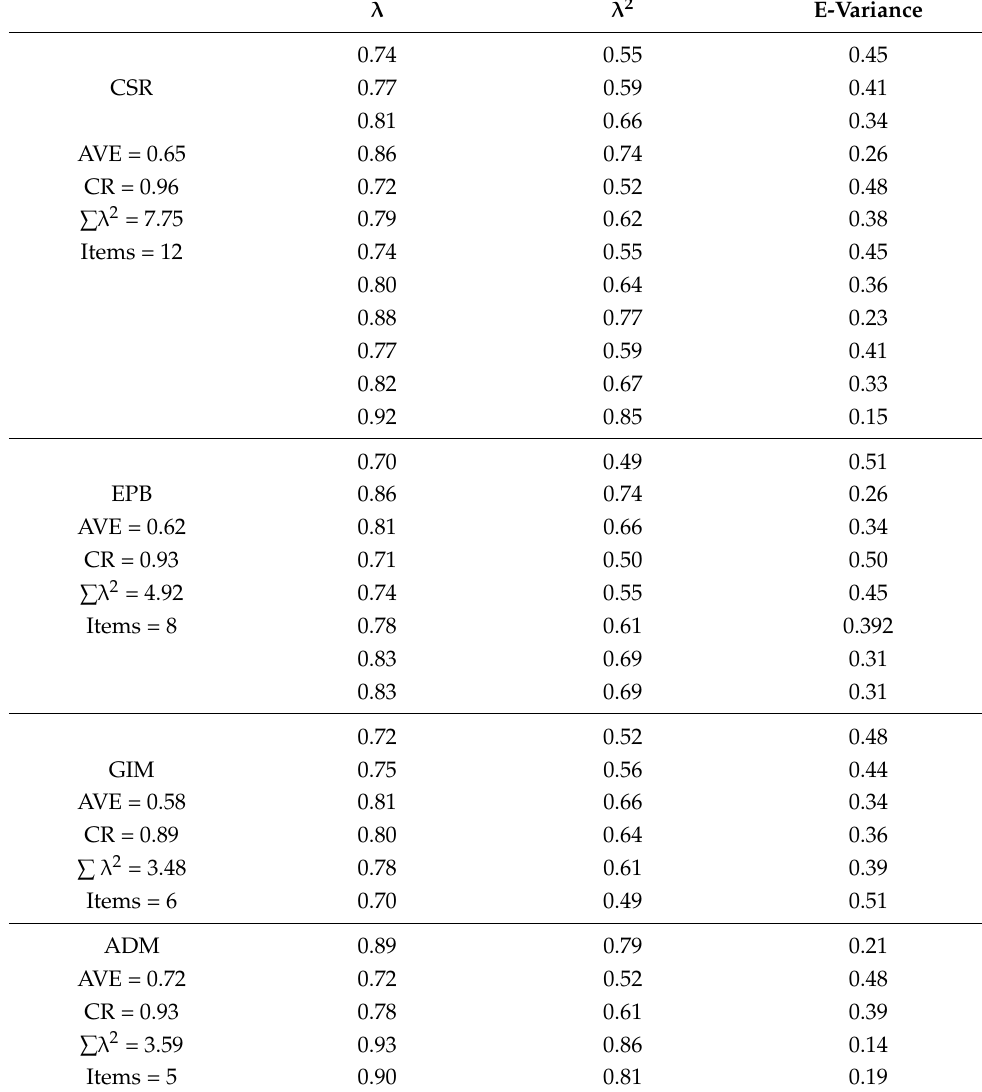
Table 3. Summary of initial analyses.